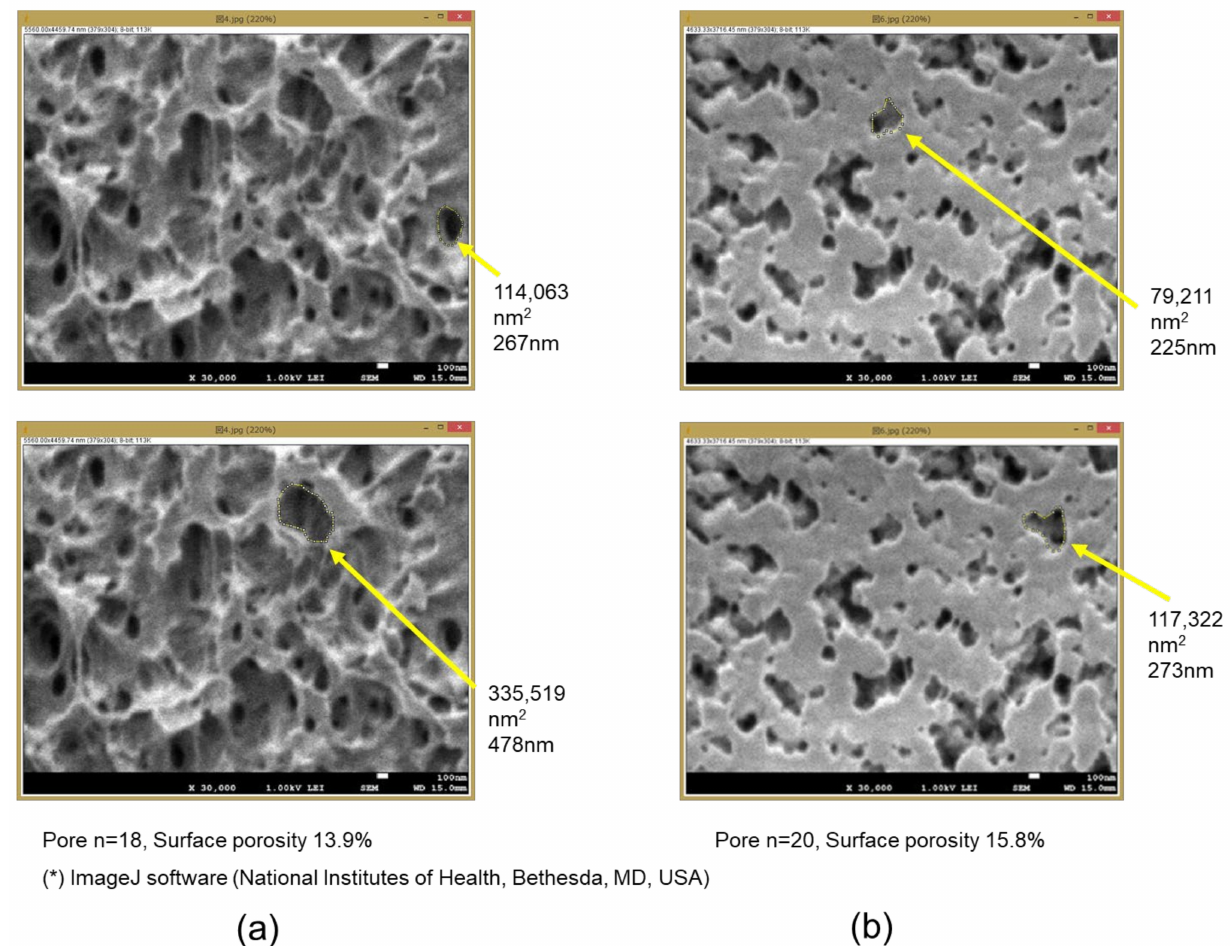
Figure 5. Measurement of pore areas and calculation of equivalent pore diameter and membrane surface porosity. ( a ) The inner lumen surface of sample A, ( b ) the inner lumen surface of sample B,